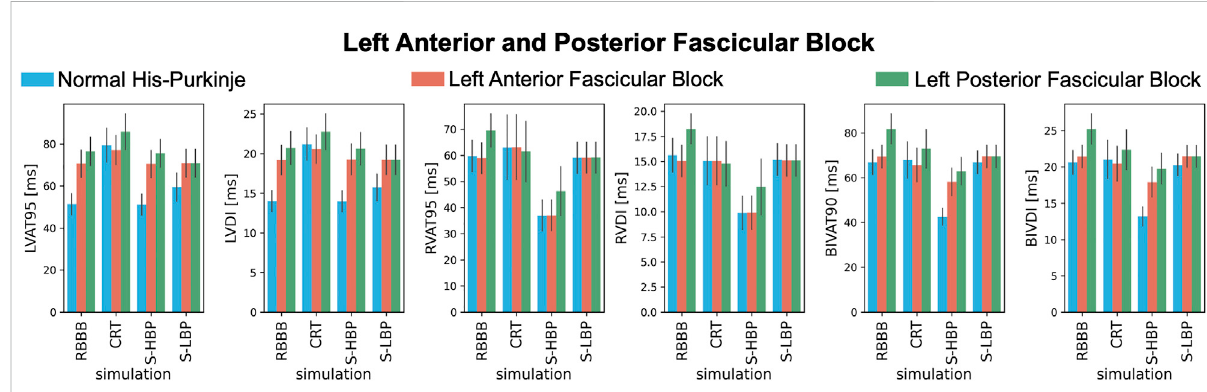
FIGURE 5 Response with RBBB, left anterior or posterior fascicular block: LVAT-95, LVDI, RVAT-95, RVDI, BIVAT-90, and BIVDI simulated in the presence of proximal RBBB combined with otherwise normal His-Purkinje system (blue bars), left anterior fascicular block (orange bars) and left posterior fascicular block (green bars). Activation was simulated during baseline, standard CRT, selective HBP (S-HBP) and selective LBP (S-LBP). Results are presented as mean ± standard